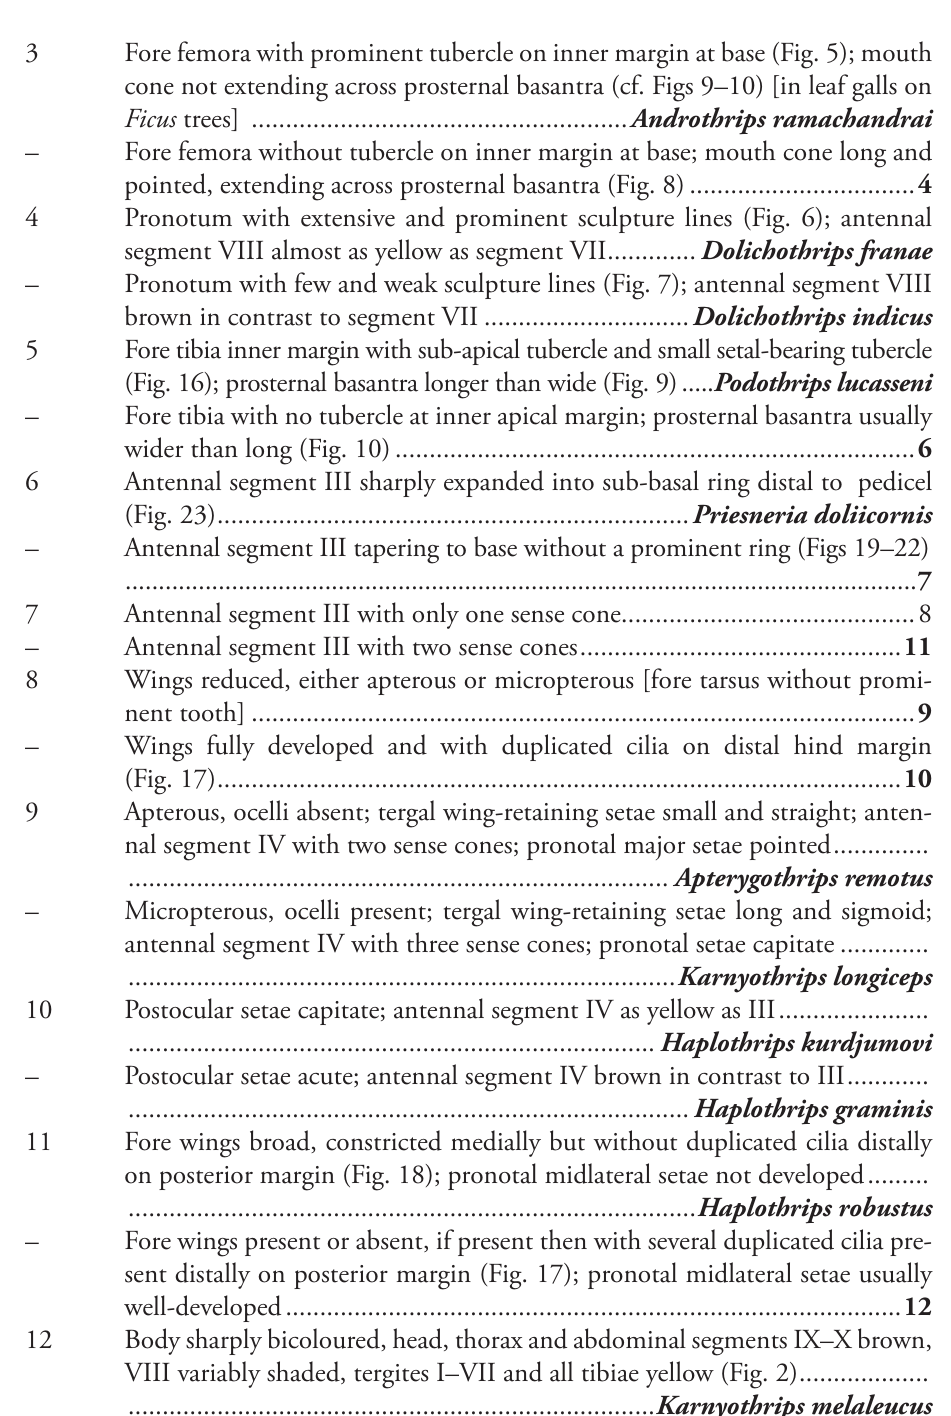
Fore femora with prominent tubercle on inner margin at base (Fig. 5); mouth cone not extending across prosternal basantra (cf. Figs 9–10) [in leaf galls on – Fore femora without tubercle on inner margin at base; mouth cone long and pointed, extending across prosternal basantra (Fig. 8) ................................. 4 4 Pronotum with extensive and prominent sculpture lines (Fig. 6); antennal segment VIII almost as yellow as segment VII ............. Dolichothrips franae – Pronotum with few and weak sculpture lines (Fig. 7); antennal segment VIII brown in contrast to segment VII .............................. Dolichothrips indicus 5 Fore tibia inner margin with sub-apical tubercle and small setal-bearing tubercle (Fig. 16); prosternal basantra longer than wide (Fig. 9) ..... Podothrips lucasseni – Fore tibia with no tubercle at inner apical margin; prosternal basantra usually wider than long (Fig. 10) ............................................................................ 6 6 Antennal segment III sharply expanded into sub-basal ring distal to pedicel (Fig. 23) ..................................................................... Priesneria doliicornis – Antennal segment III tapering to base without a prominent ring (Figs 19–22) 7 Antennal segment III with only one sense cone...........................................8 – Antennal segment III with two sense cones ............................................... 11 8 Wings reduced, either apterous or micropterous [fore tarsus without promi- – Wings fully developed and with duplicated cilia on distal hind margin (Fig. 17) .................................................................................................... 10 9 Apterous, ocelli absent; tergal wing-retaining setae small and straight; anten- nal segment IV with two sense cones; pronotal major setae pointed .............. – Micropterous, ocelli present; tergal wing-retaining setae long and sigmoid; antennal segment IV with three sense cones; pronotal setae capitate ............. 10 Postocular setae capitate; antennal segment IV as yellow as III ...................... – Postocular setae acute; antennal segment IV brown in contrast to III ............ 11 Fore wings broad, constricted medially but without duplicated cilia distally on posterior margin (Fig. 18); pronotal midlateral setae not developed ......... – Fore wings present or absent, if present then with several duplicated cilia pre- sent distally on posterior margin (Fig. 17); pronotal midlateral setae usually well-developed .......................................................................................... 12 12 Body sharply bicoloured, head, thorax and abdominal segments IX–X brown, VIII variably shaded, tergites I–VII and all tibiae yellow (Fig. 2) ...................